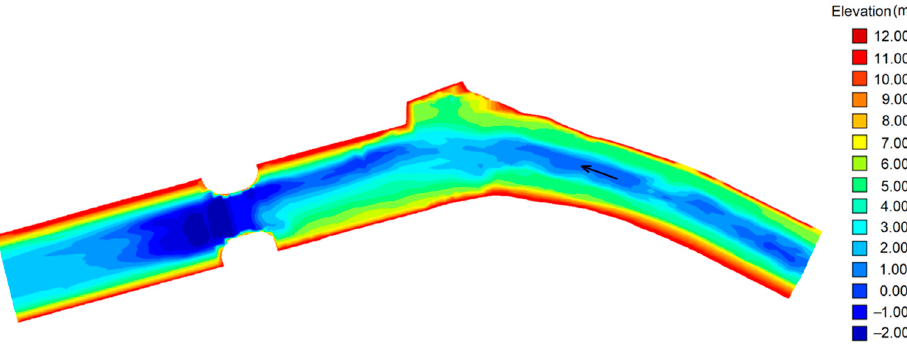
Figure 2 . Layout of the sluice structure. ( a ) cross-sectional view (looking downstream); ( b ) plan view. Including all the piers, the concrete sluice structure is 60 m long.